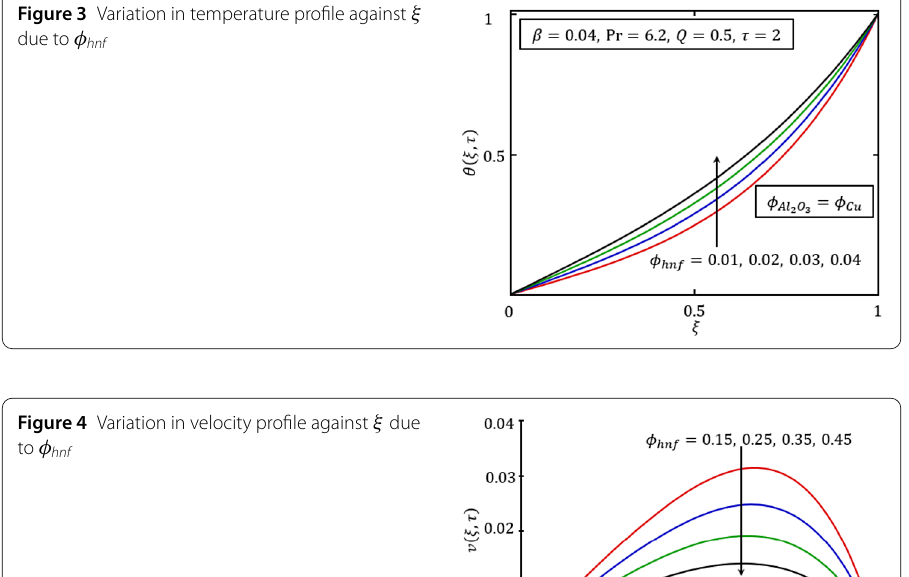
Figure 4 Variation in velocity profile against ξ due to φ hnf